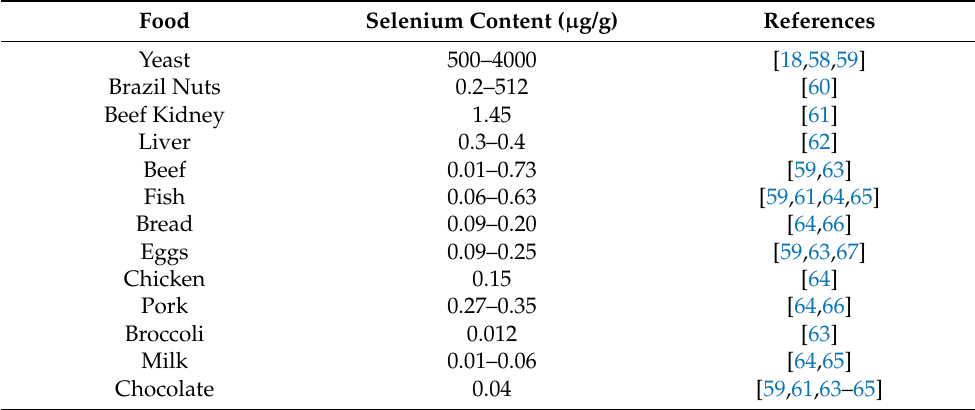
Table 3. Selenium content in food products according to reference